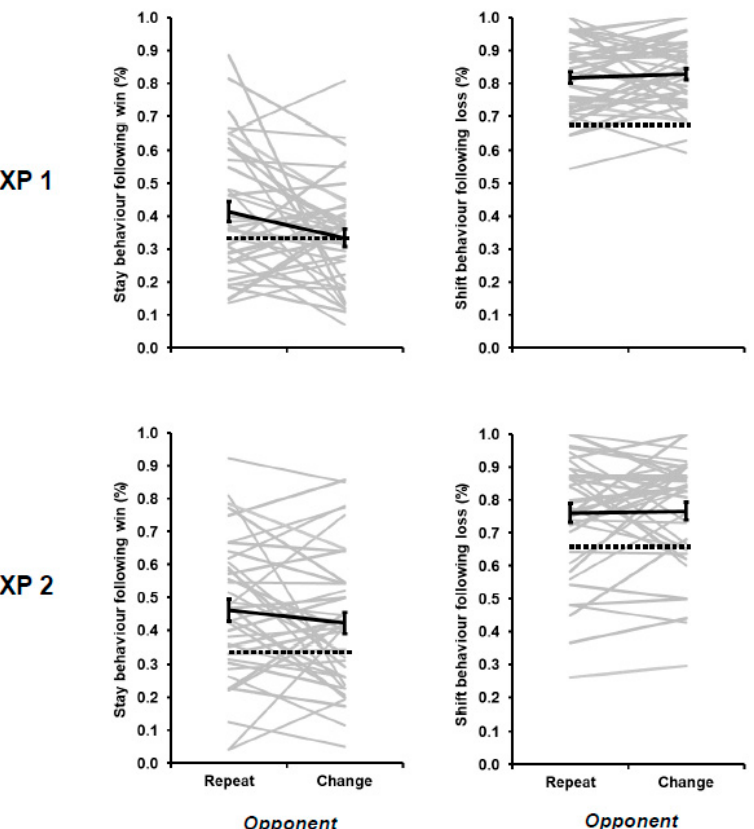
Figure 1. Individual (grey) and group (black) data for win–stay and lose–shift proportions across opponent repeat and opponent change trial pairs in Experiments 1 and 2. Error bars represent standard error. Dotted line represents proportion of win–stay (0.333) and lose–shift (0.666) behavior expected from unpredictable performance.